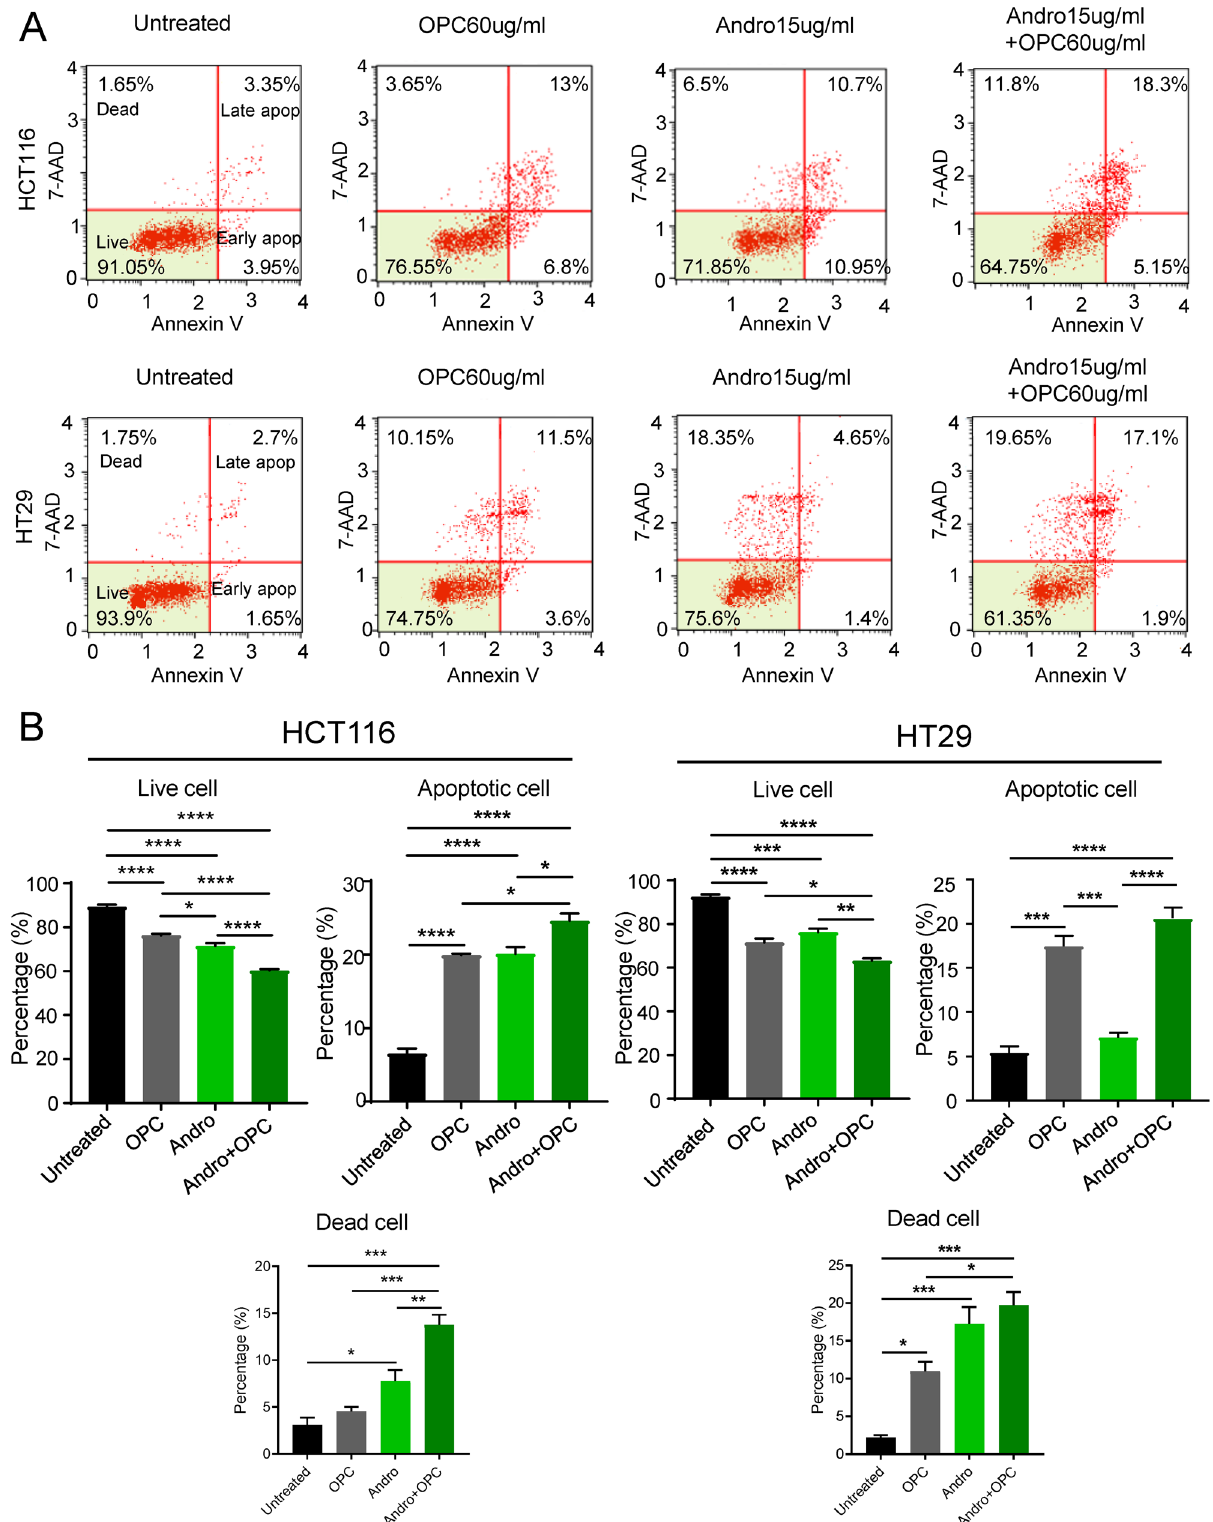
Figure 2. The combination of Andrographis and OPCs enhanced apoptotic activity in CRC cells. ( A ) Representative images illustrating percentage of cells undergoing apoptosis that stained positive for annexin-V assay in HCT116 and HT29 cells. The units are log10 transformed. ( B ) Bar graph shows the percentage of live cells and apoptotic cells of each treatment group in apoptosis assay. The assays were performed 48 h after treatment of each agent. Statistical Significance is as follows; *P < 0.05, **P < 0.01, ***P < 0.001, and ****P < 0.0001 by one-way ANOVA